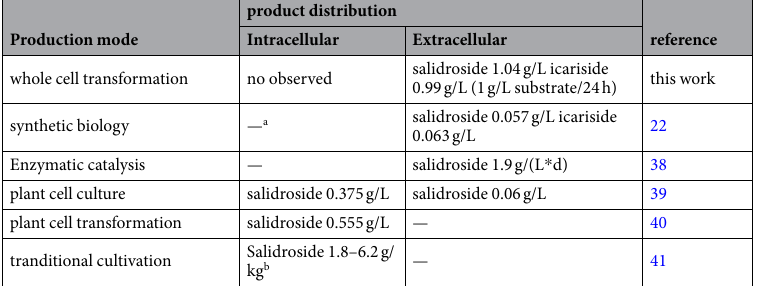
Table 3. The synthesis of salidroside: a comparison with literature results. a No reported in lecture. b Dry